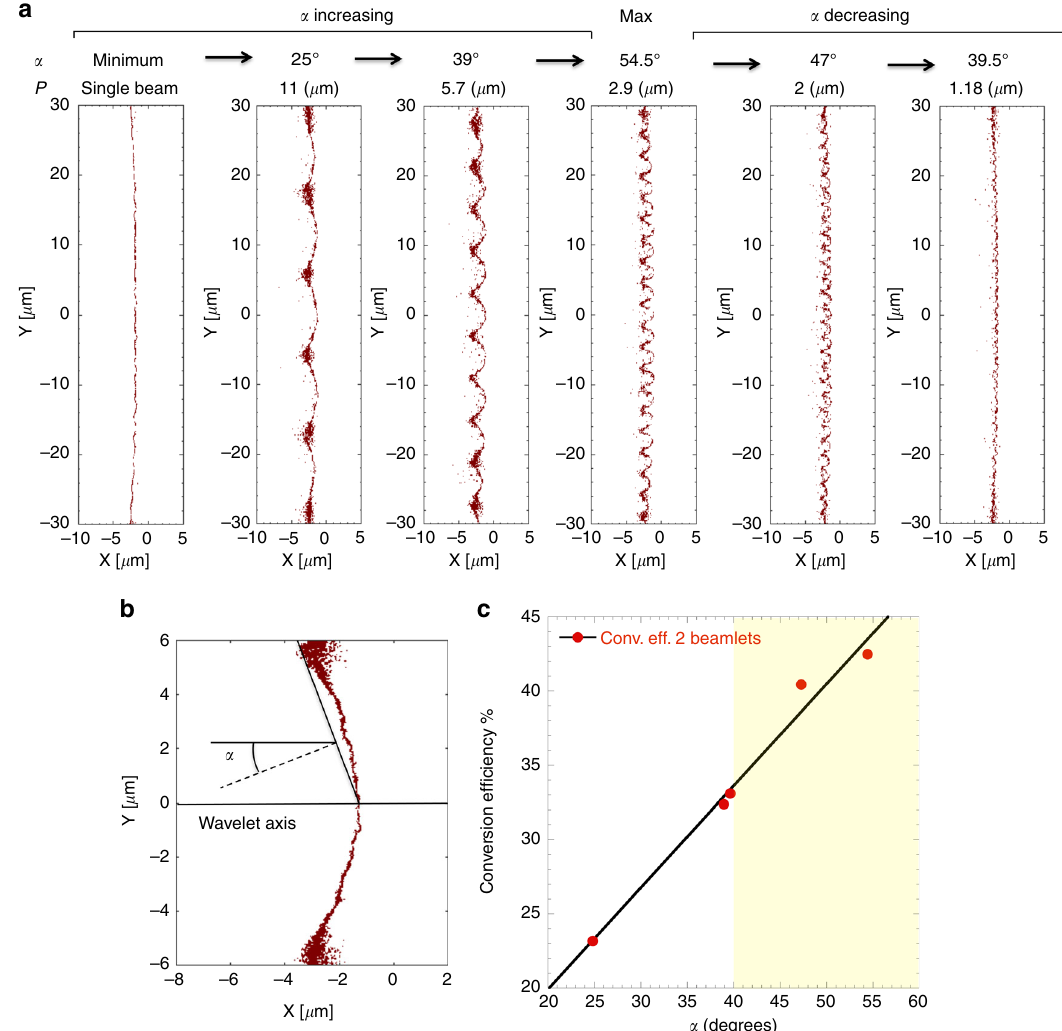
Fig. 3 De fi nition of the modulation angle α and its relation to the conversion ef fi ciency. a Plasma electron density pro fi le with 1.5 n c ≤ n e ≤ 6 n c for single beamlet and 2-beamlet interaction for all values of P investigated. The single beamlet case shows a rather uniform density pro fi le while the 2-beamlets cases shows a signi fi cant surface modulation with period corresponding to the interference intensity pattern. For larger periods (2.9 μ m ≤ P ≤ 11 μ m) the depth of the surface modulation is approximately constant, leading to larger values of α as P decreases. However, for P < 2.9 μ m the modulation depth also decreases since the wavelets full width at half maximum approaches the electron excursion length in the laser fi eld. This leads to the saturation of α reaching its maximum for P = 2.9 μ m and subsequently decreasing for smaller values of P . b Representation of a single wavelet-induced modulation for P = 11 μ m. The average modulation angle α is de fi ned as the average wavelet incidence angle on the plasma critical surface. c Laser-to-electron energy conversion ef fi ciency as function of the average surface modulation angle α . The conversion ef fi ciency linearly increases for all values of α . The dashed line- delimited area above 40 degrees represents the region where saturation and decline of conversion ef fi ciency for forward moving electrons is Fig. 4a, b are represented the J y component of the fast electron current density and the associated magnetic fi eld for single wavelet-induced modulation and interference period P = 11 μ m.